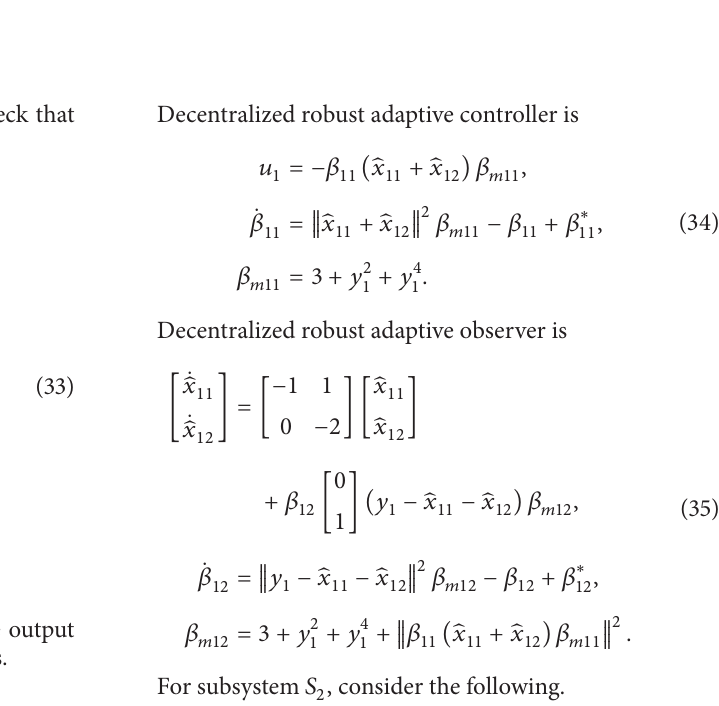
Figure 5: Simulation results of the estimation errors with 𝛽 ∗ 11 = 80 , 𝛽 ∗ 12 = 100 , 𝛽 ∗ 21 = 120 , and 𝛽 ∗ 22 = 140